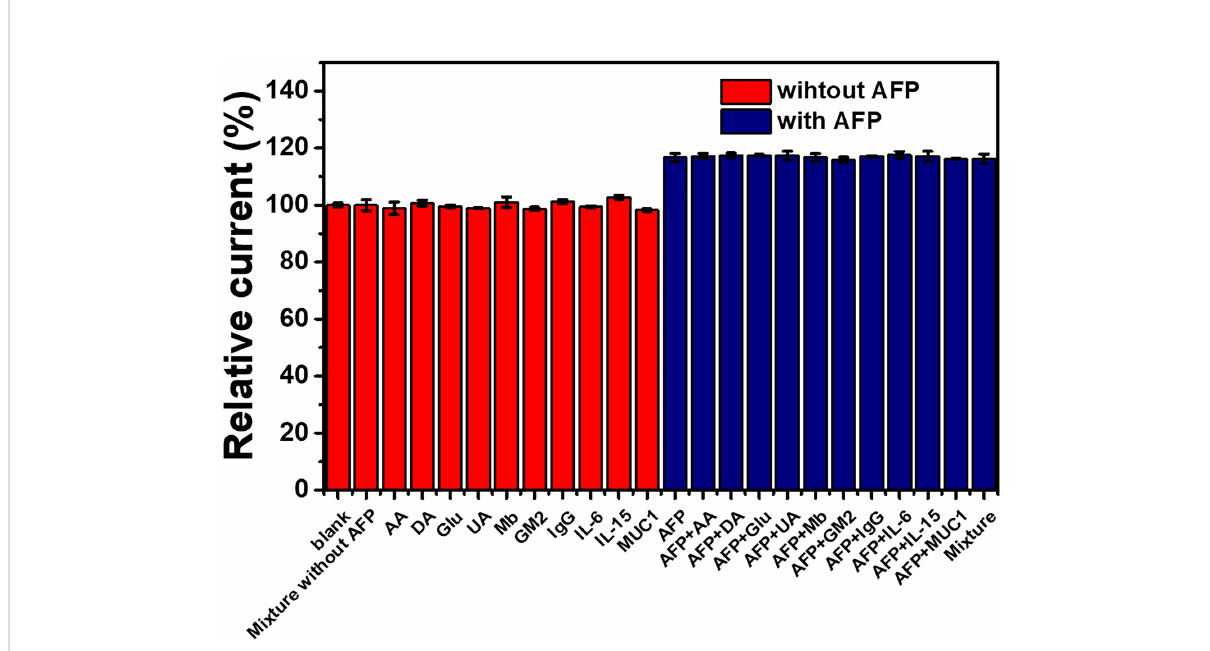
FIGURE 7 Interference study of the immunosensor incubated with different solutions: blank (PBS), individual and mixed interference solutions (100 ng ml -1 ), and 1 ng ml -1 AFP solutions without and with the presence of individual and mixed interferences (100 ng ml -1